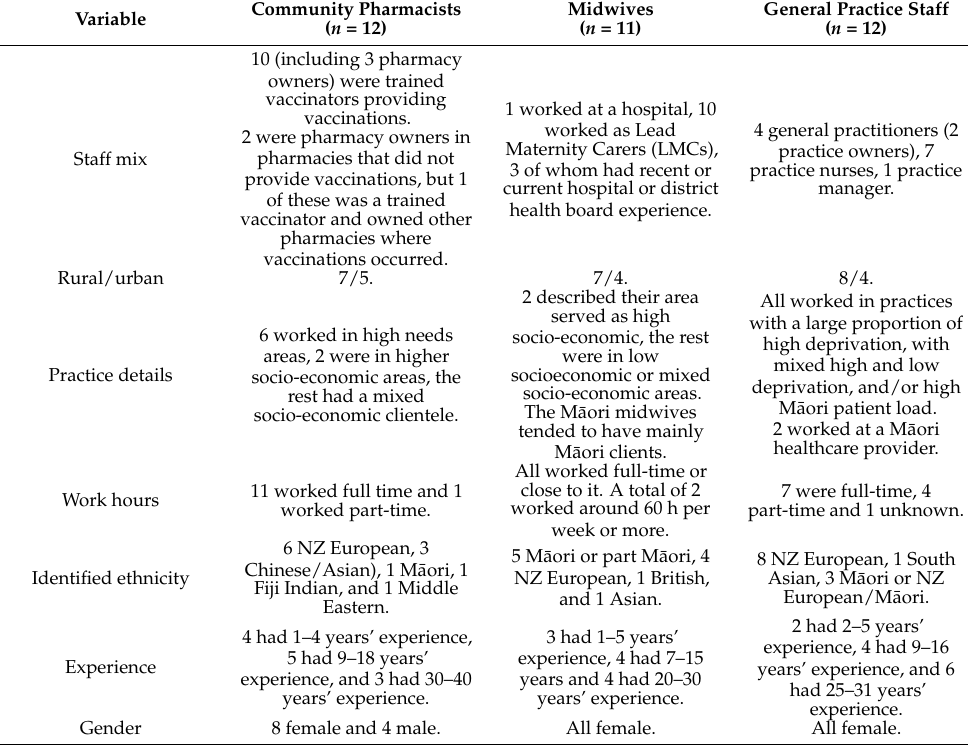
Table 2. Characteristics of the enrolled and interviewed health care providers ( n =